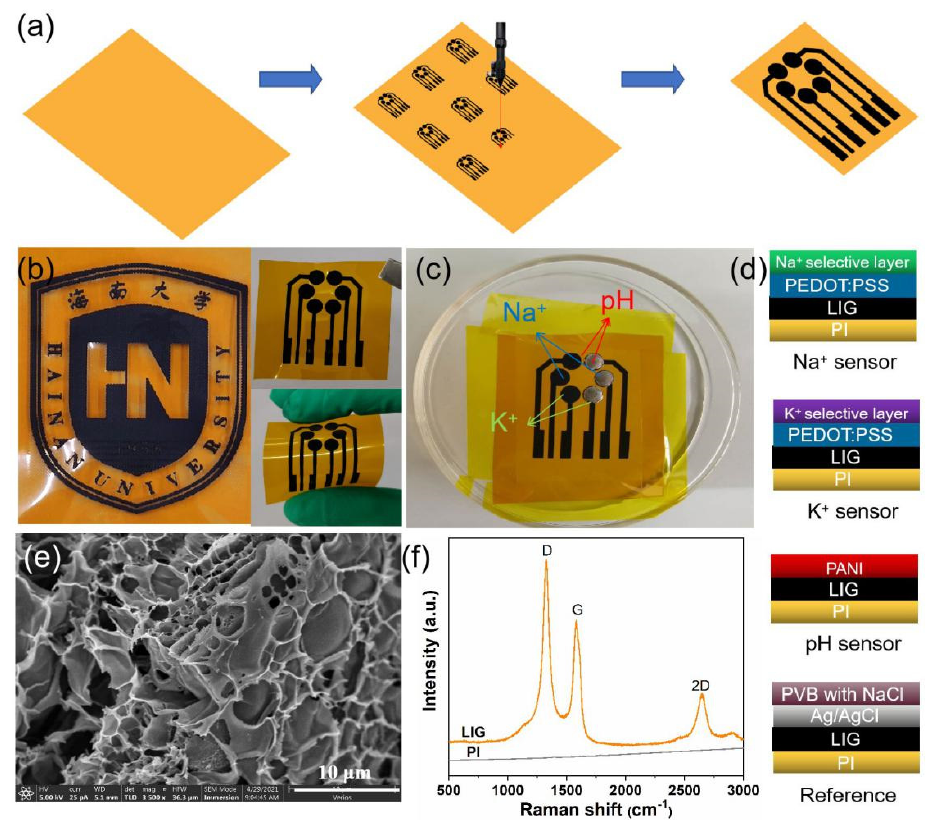
Figure 1. ( a ) Schematic illustration of the fabrication process of LIG electrodes; ( b ) photograph of the logo of Hainan University fabricated by LIG technique, and the photographs of LIG electrodes showing excellent flexibility; ( c ) photograph of a LIG sensor after modification with corresponding ion-selective membranes (black circles, left) and Ag/AgCl ink (silvery circles, right), which could simultaneously detect Na + , K + , and pH in sweat; ( d ) schematic illustration of the structures of Na + , K + , pH sensors, and Ag/AgCl reference electrodes; ( e ) SEM image and ( f ) Raman spectra of LIG layer.